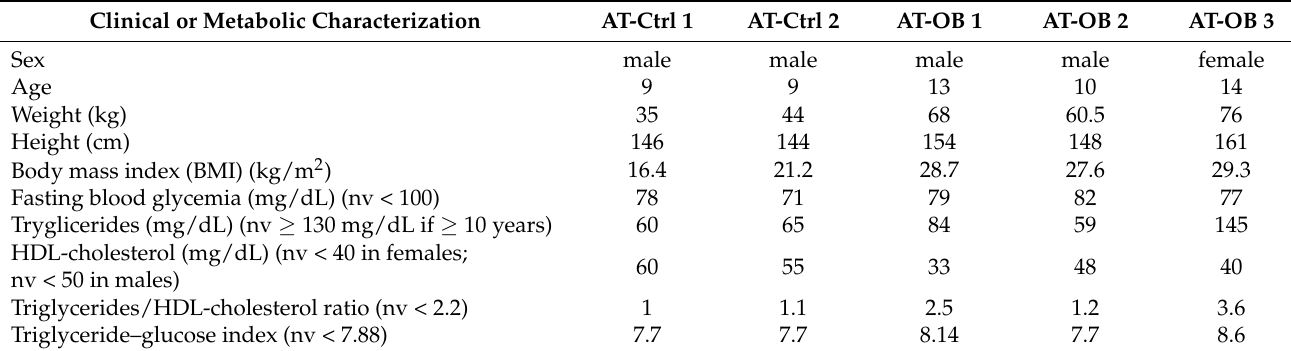
Table 1. Clinical and metabolic features of the AT-Ctrl and